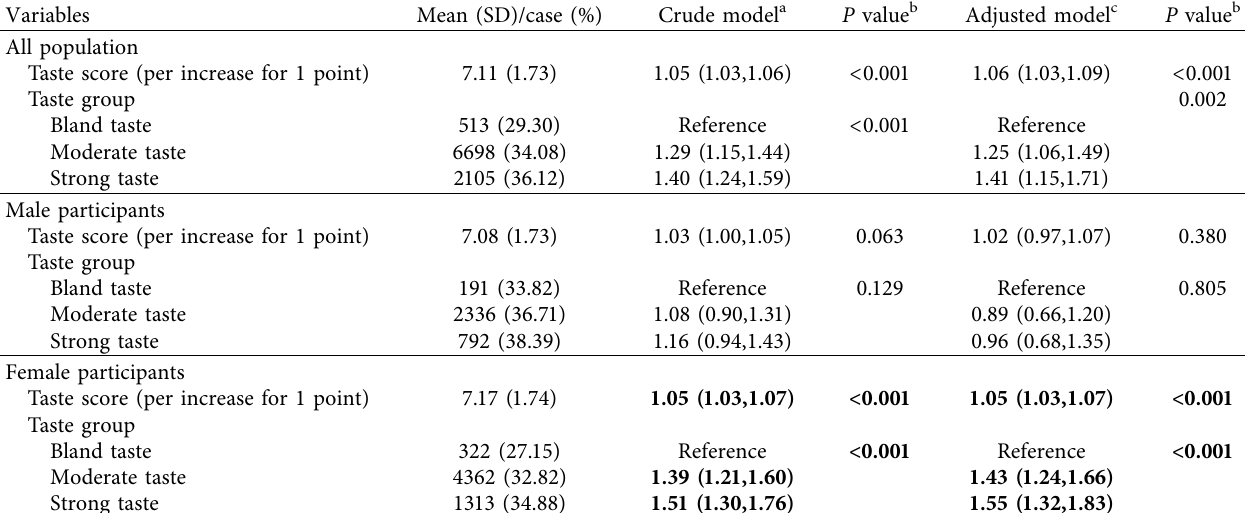
Table 2: Odds ratios (95% CIs) of hypertension across taste scores for all participants.